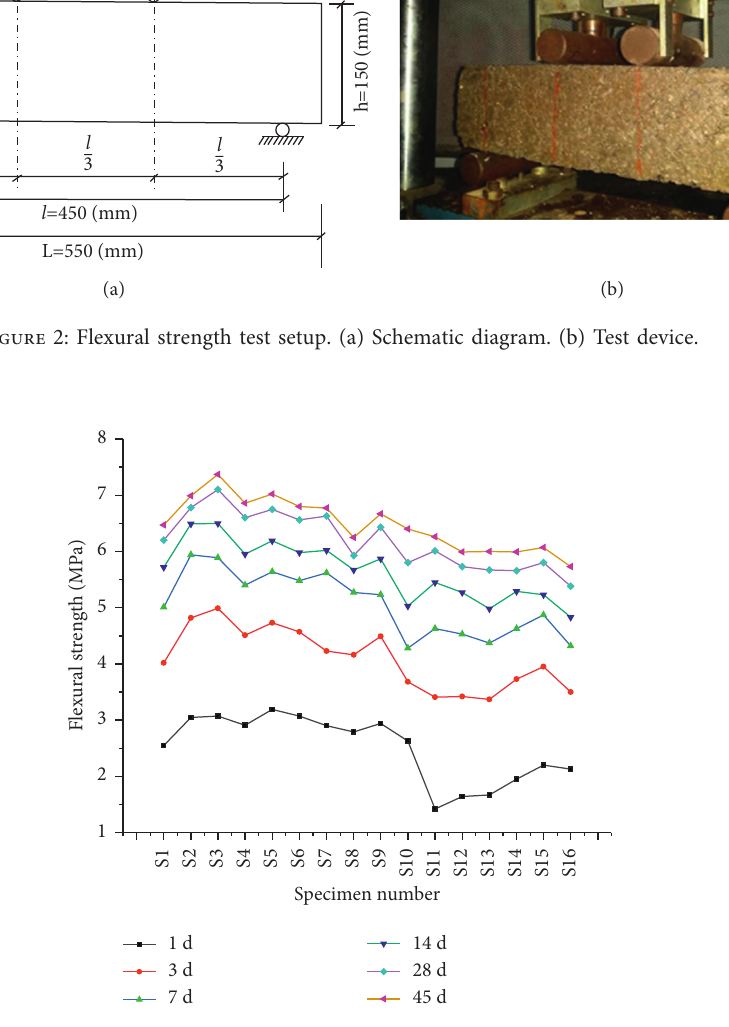
Figure 3: Variation of the flexural strengths of concrete specimens with different ages.